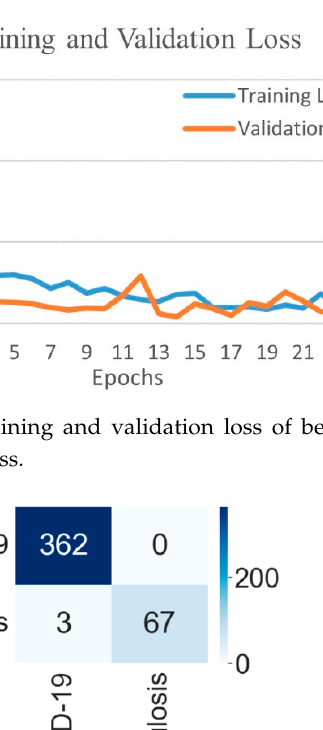
Figure 13. Training and validation accuracy of best performing VGG16 model for COVID-19 and tuberculosis class.